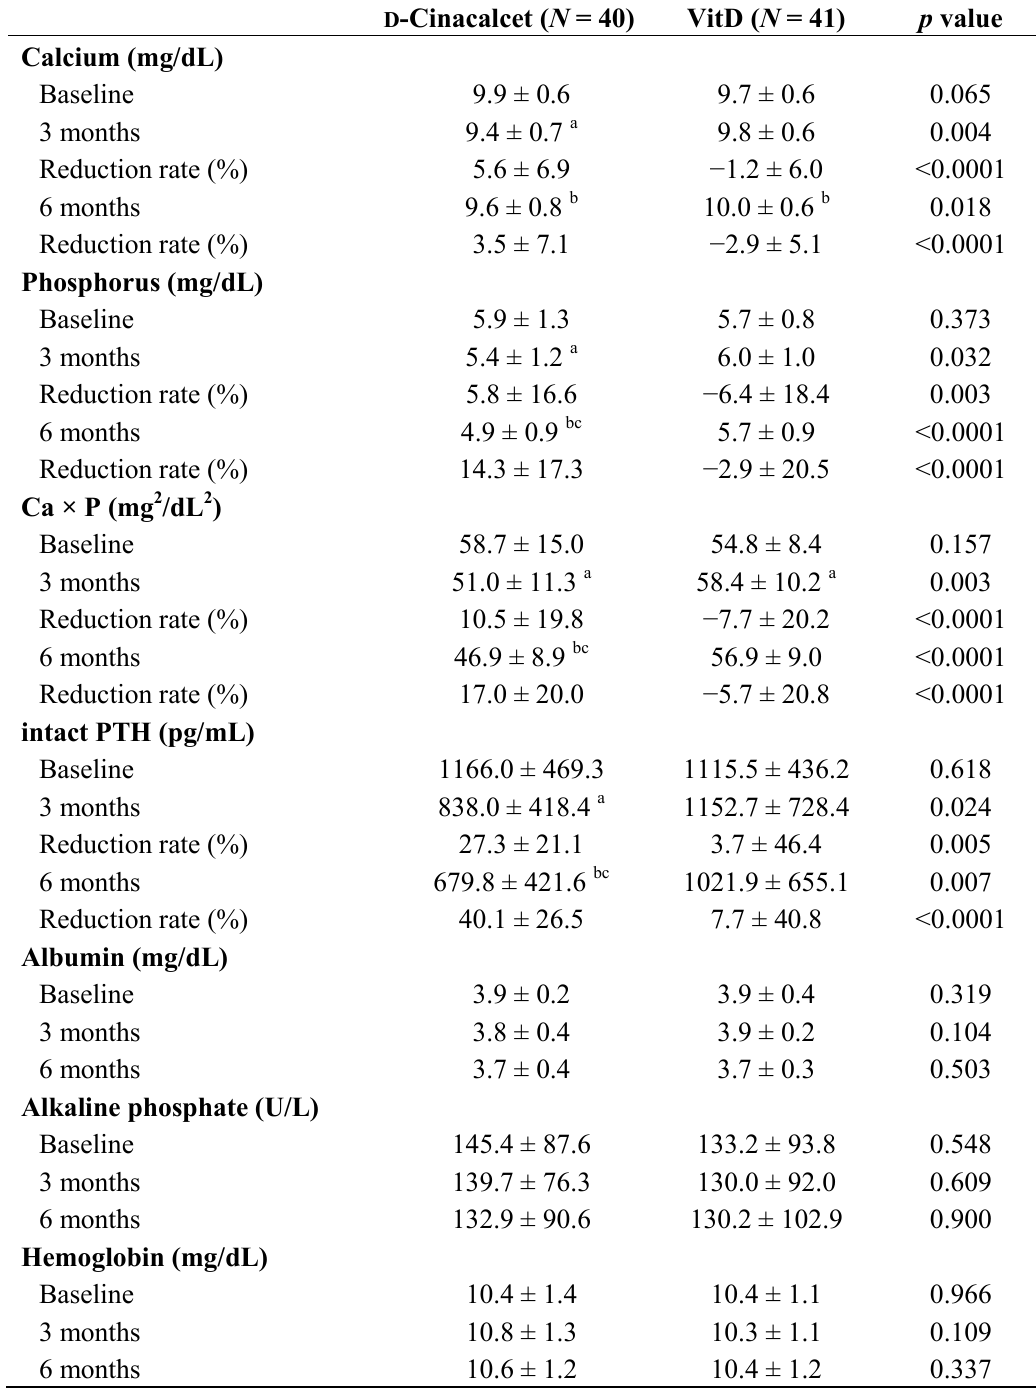
a Comparison between baseline and 3 months, p < 0.05; b Comparison between baseline and 6 months, p < 0.05; c Comparison between 3 months and 6 months, p <